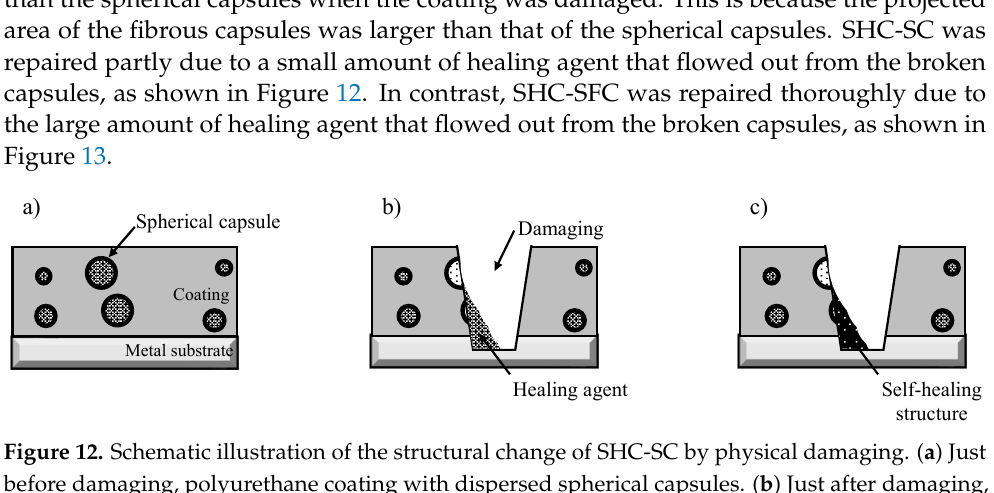
Figure 11. Schematic illustration of the structural change of the self-healing coating with dispersed spherical and fibrous capsules (SHC-SFC) during aging. ( a ) Just after coating the mixture of prepoly- mer/ethylene glycol/spherical and fibrous capsules/cyclohexanone. ( b ) During aging, reaction of prepolymer with ethylene glycol and evaporation of cyclohexanone. ( c ) In the last stage of aging, the formation of polyurethane and film thinning, leading to an increase in capsule density as well as fibrous capsule being aligned parallel to the specimen surface.